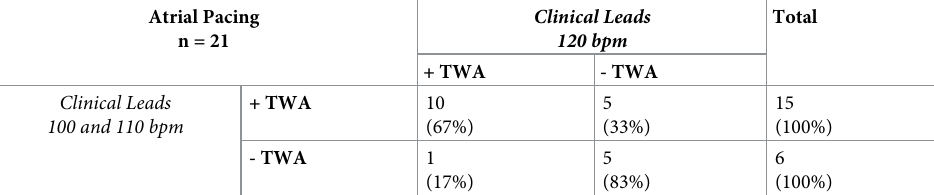
Table 4. Effect of pacing rate on clinically +TWA during atrial pacing.